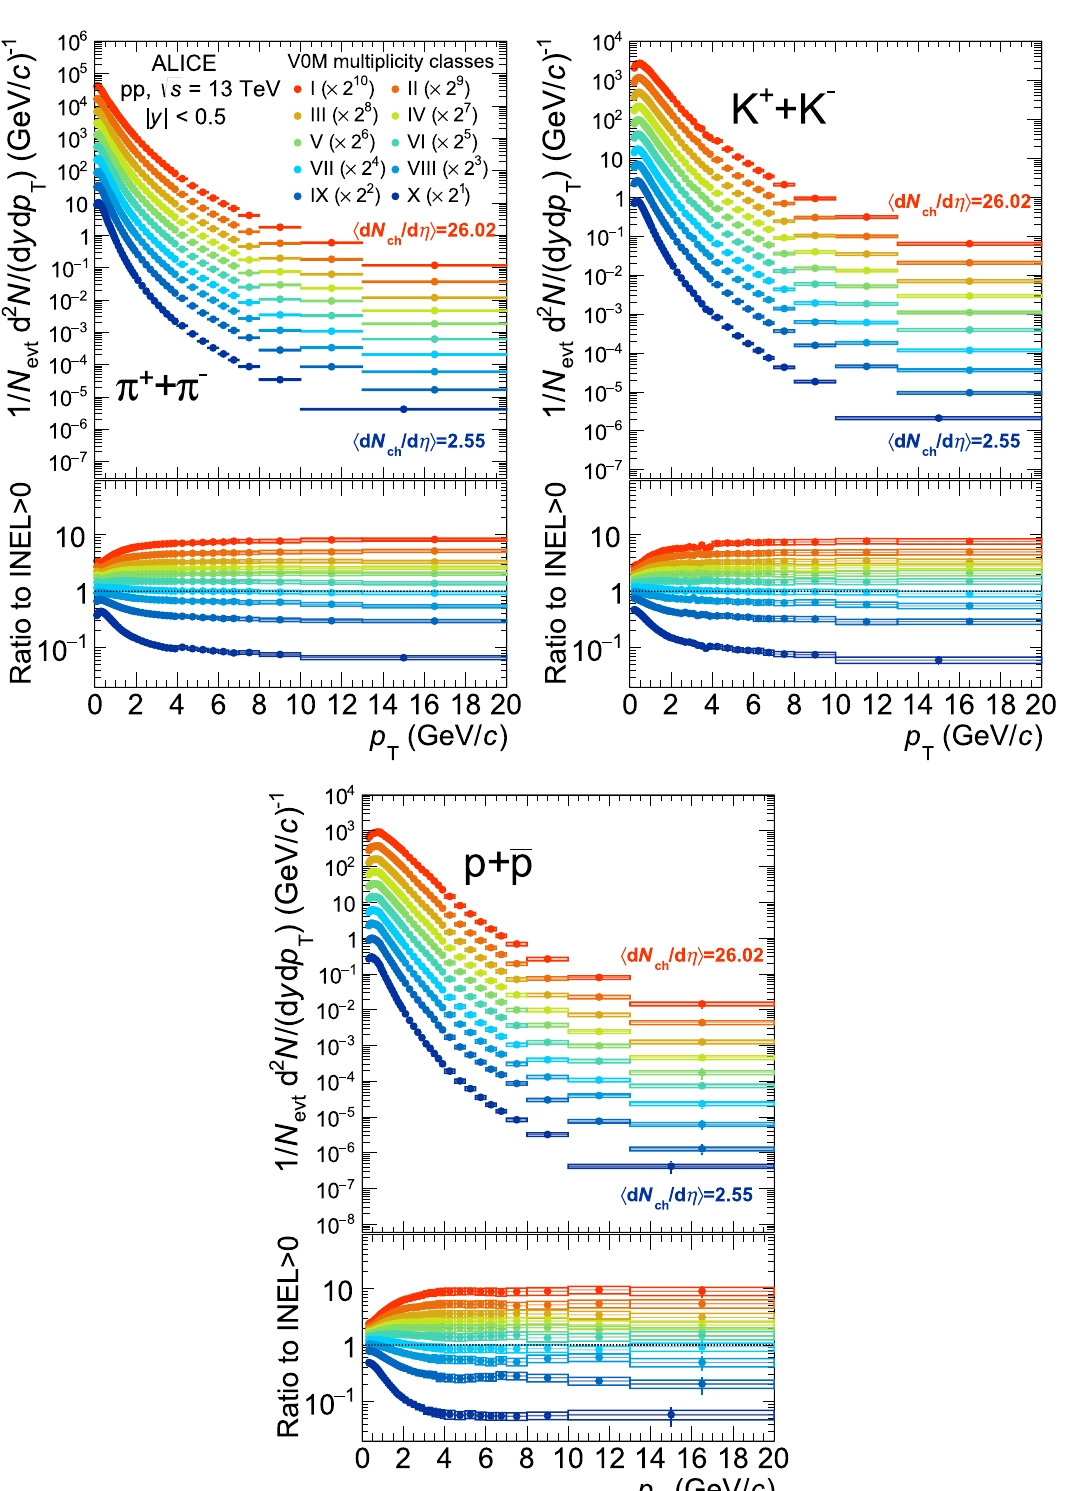
Fig. 1 Transverse momentum spectra of π , K, and p for different multiplicity event classes. Spectra are scaled by powers of 2 in order to improve visibility. The corresponding ratios to INEL > 0 spectra are shown in the bottom